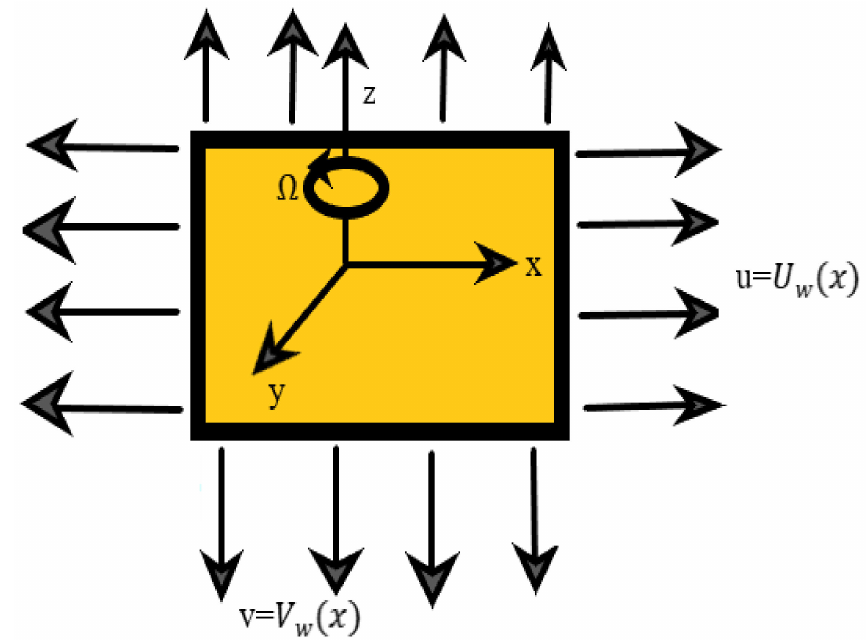
Figure 1. The geometry and coordinate